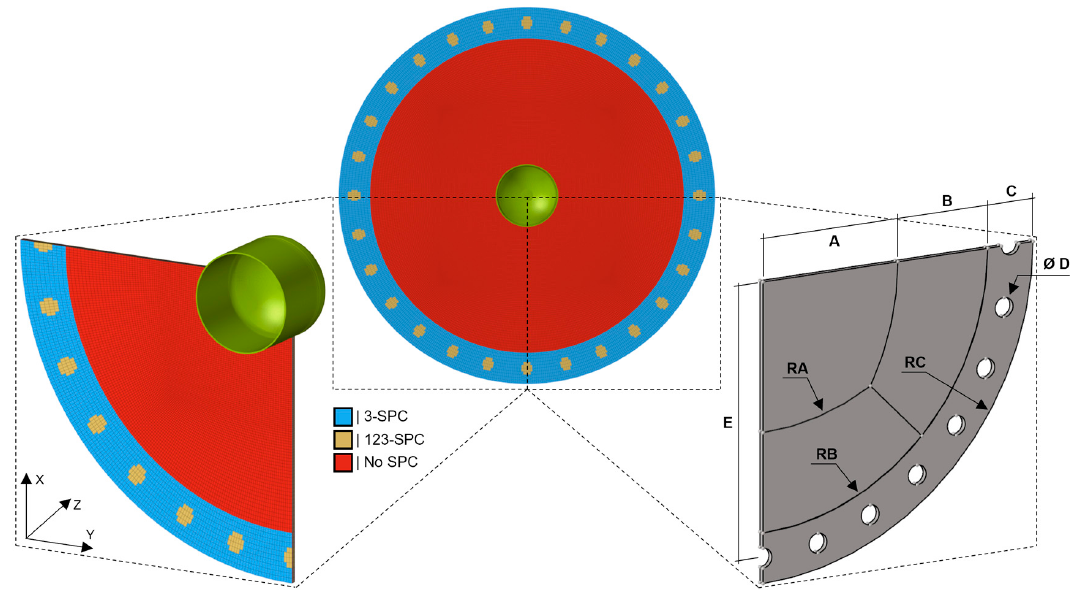
Figure 5. The schematization of the FE numerical model: geometry and constraints. Table 13. Geometrical dimension of associated composite panel.